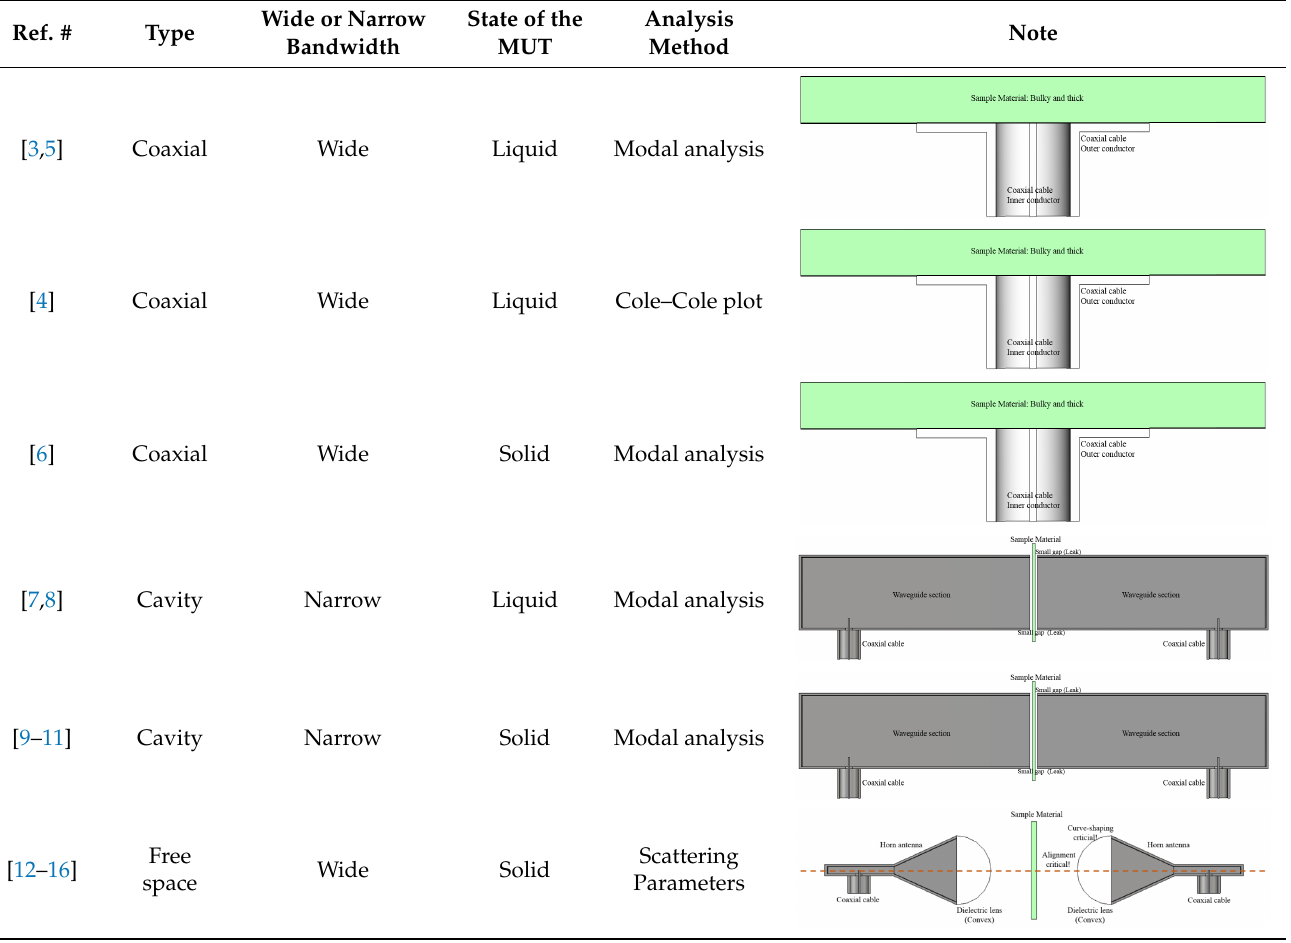
Table 1. Features of the conventional dielectric–constant finding methods.